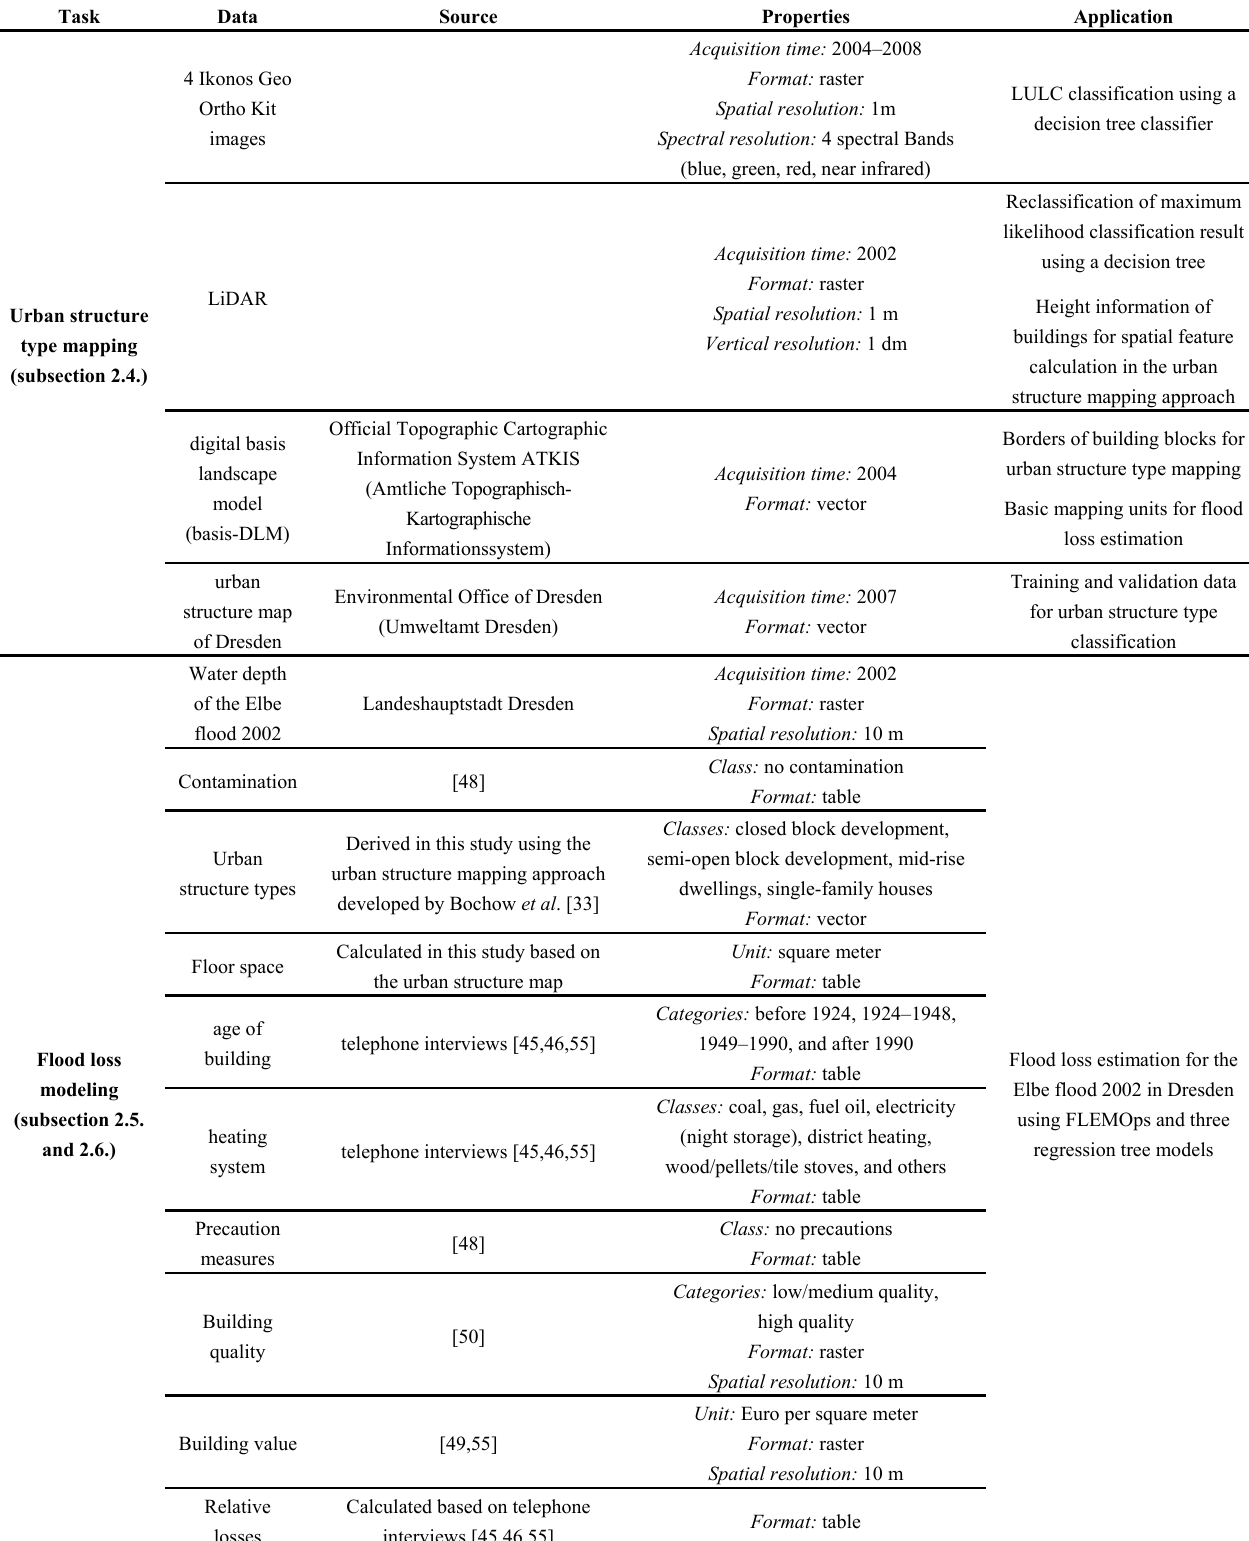
Table 1. Input data for urban structure mapping and flood loss